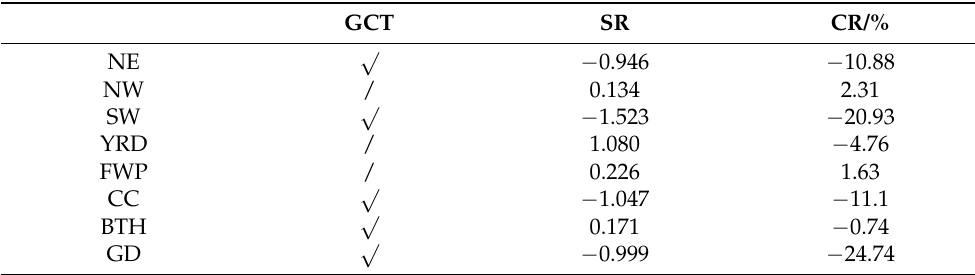
Table 5. Driving force analysis performed on a regional scale between AOD and VCF in major regions in China.